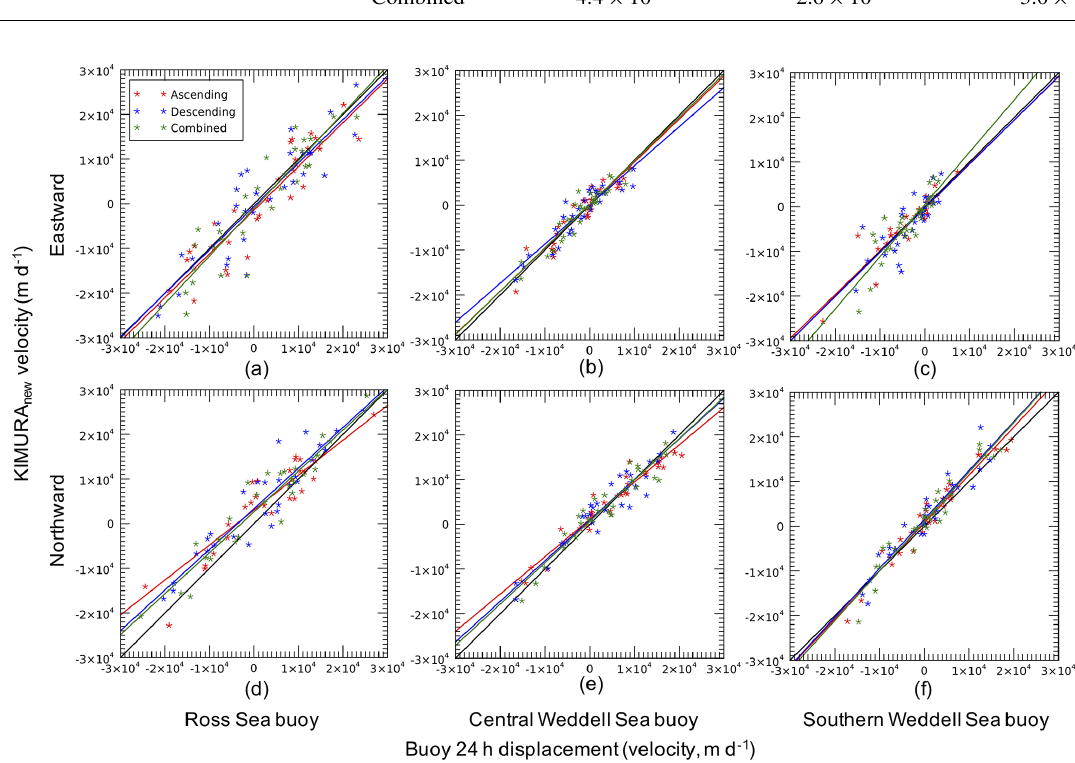
Figure 5. Scatterplot of comparisons between KIMURA new dataset (ASC is red, DES is blue, and combined is green) and buoy velocities (24h displacement) in eastward ( a , b , and c ) and northward ( d , e , and f ) directions in October 2017 for the Ross Sea buoy, July 2018 for central Weddell Sea buoy, and May 2018 for southern Weddell Sea buoy. The solid black line represents the regression slope of 1.0.